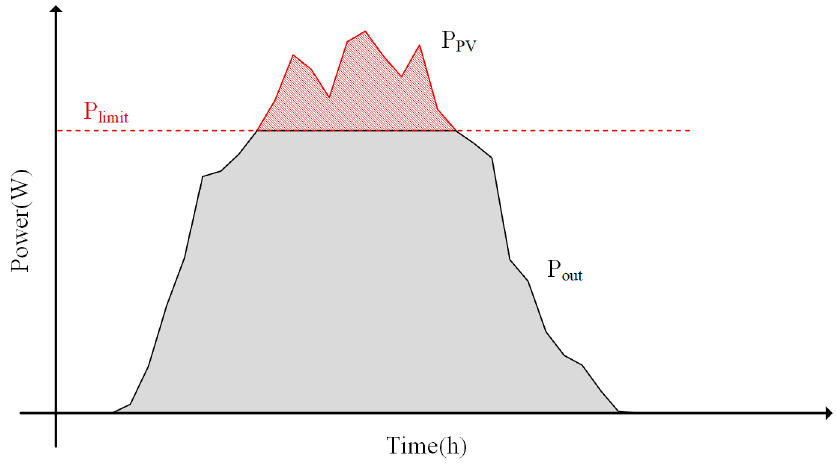
Figure 8. Conceptual diagram of determining the maximum power output limit.